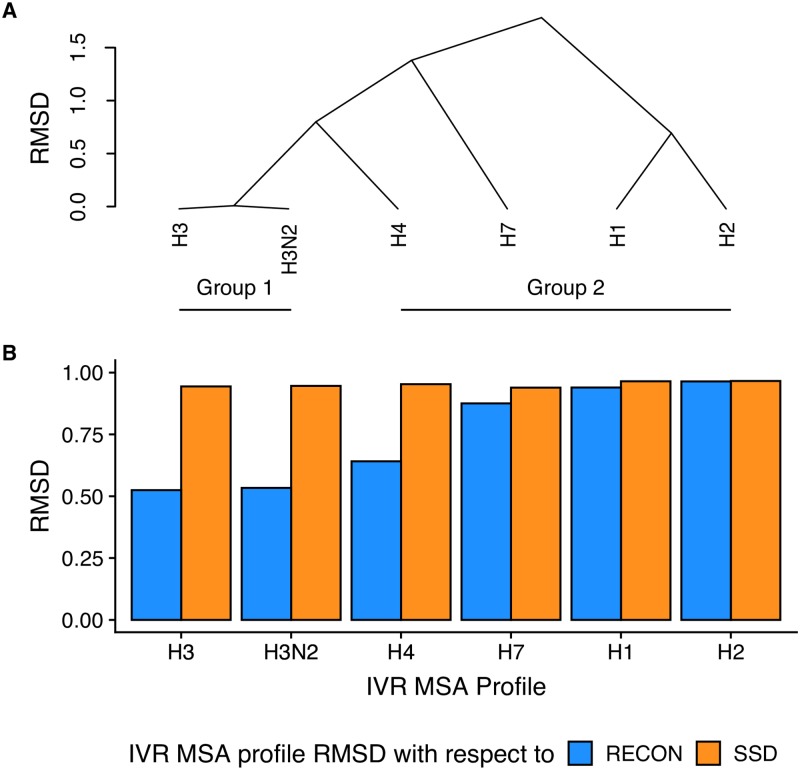
Root mean square deviations of residue mutation frequencies of influenza A subtypes and HA2 profiles predicted by RECON MSD and SSD.(A) Dendrogram of root mean square deviations (RMSD) of influenza A subtype HA2 profiles sorted by pairwise RMSD. The mutation frequencies derived from the multiple sequence alignment profile of each influenza A subtype was compared to all other subtypes by calculating the mean standard deviation of each aligned position’s mean sum of squared differences of all twenty amino acid frequencies with respect to each other subtype profile. Pairwise RMSD values were sorted to form clades, with the height along the y axis indicating the pairwise RMSD between each clade. (B) RMSD of each IVR subtype multiple sequence alignment (MSA) profile with respect to RECON MSD and SSD. The x axis represents each IVR subtype profile sorted as in Panel A. The y axis represents the RMSD, calculated in the same fashion as in Panel A, of each subtype profile in relation to either RECON MSD or SSD.